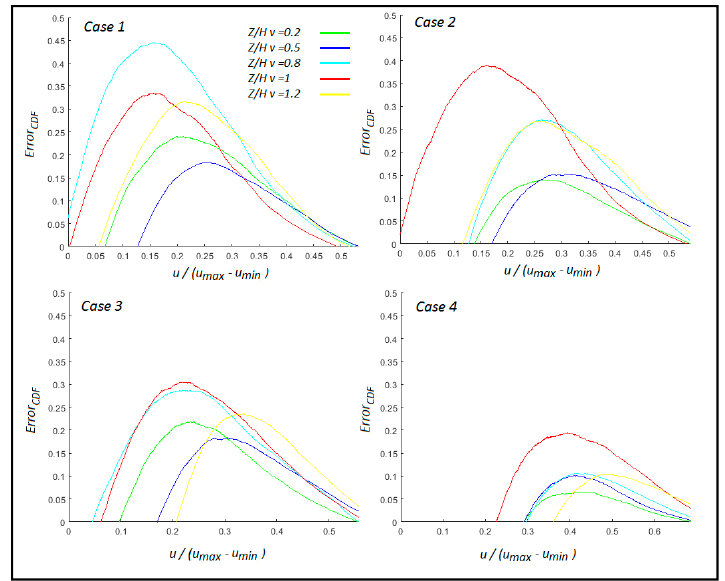
Figure 9. Values of Error CDF for different depths behind the decaying patch at a distance of x/H v = 8. According to the results of this research, the intermittency and anisotropy of the turbulence are associated with the non-Gaussian distribution of instantaneous velocity.